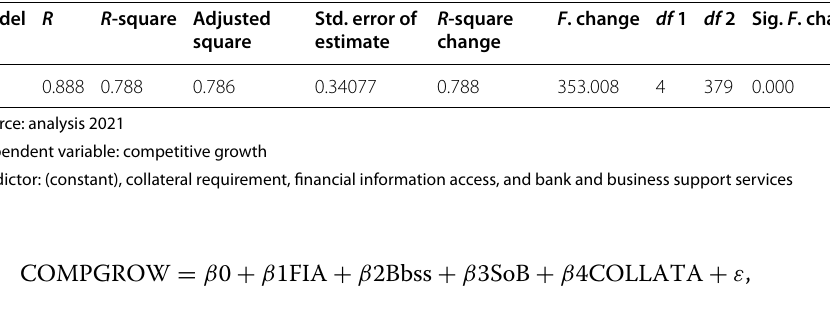
Table 3 Model summary (coefficient of determination)